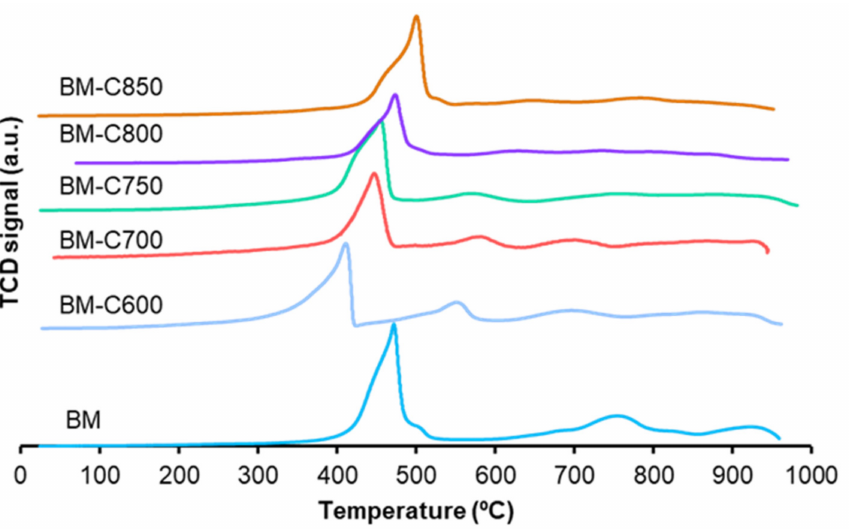
Figure 6. Hydrogen consumption profiles in TPR conditions of BM-CX series and